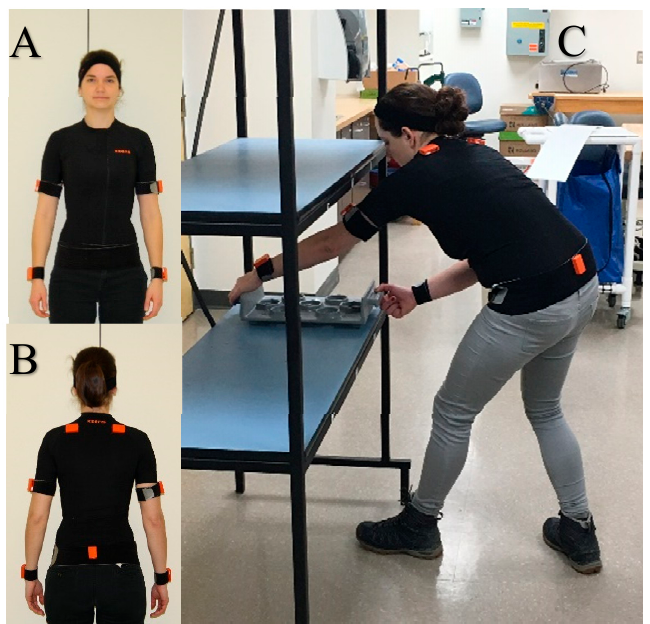
Figure 1. ( A ) Positioning example for sensors—front view, ( B ) Positioning example for sensors—back view, ( C ) Lifting trial example; for this specific trial, the left arm was analyzed as it was the arm which was farther from the body when lifting.